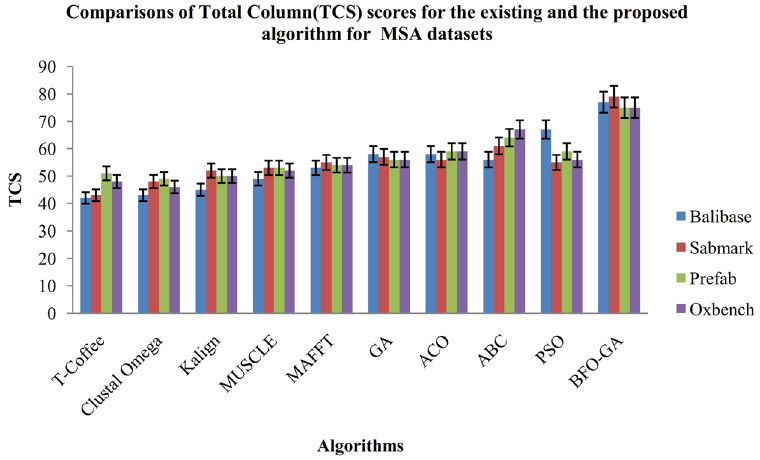
Figure 10. Comparison of Total Column Score (TCS) scores for the existing and the proposed algorithm for the MSA Datasets.